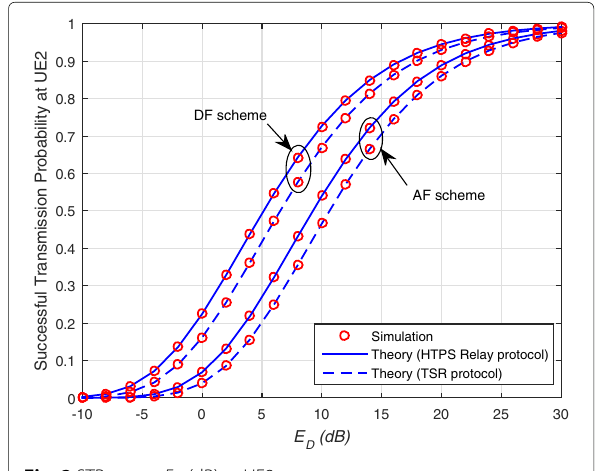
Fig. 2 STP versus E D (dB) at